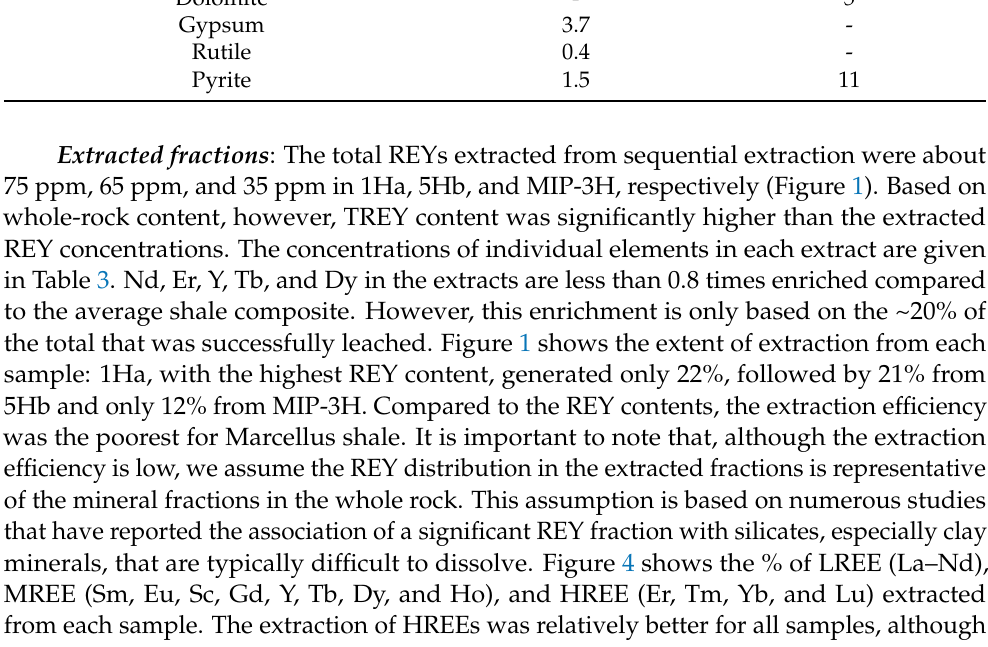
Table 2. Mineralogy of unreacted 1Ha sample determined by X-Ray Diffraction analysis and MIP- 3H from Pilewski et al., 2019 [67].